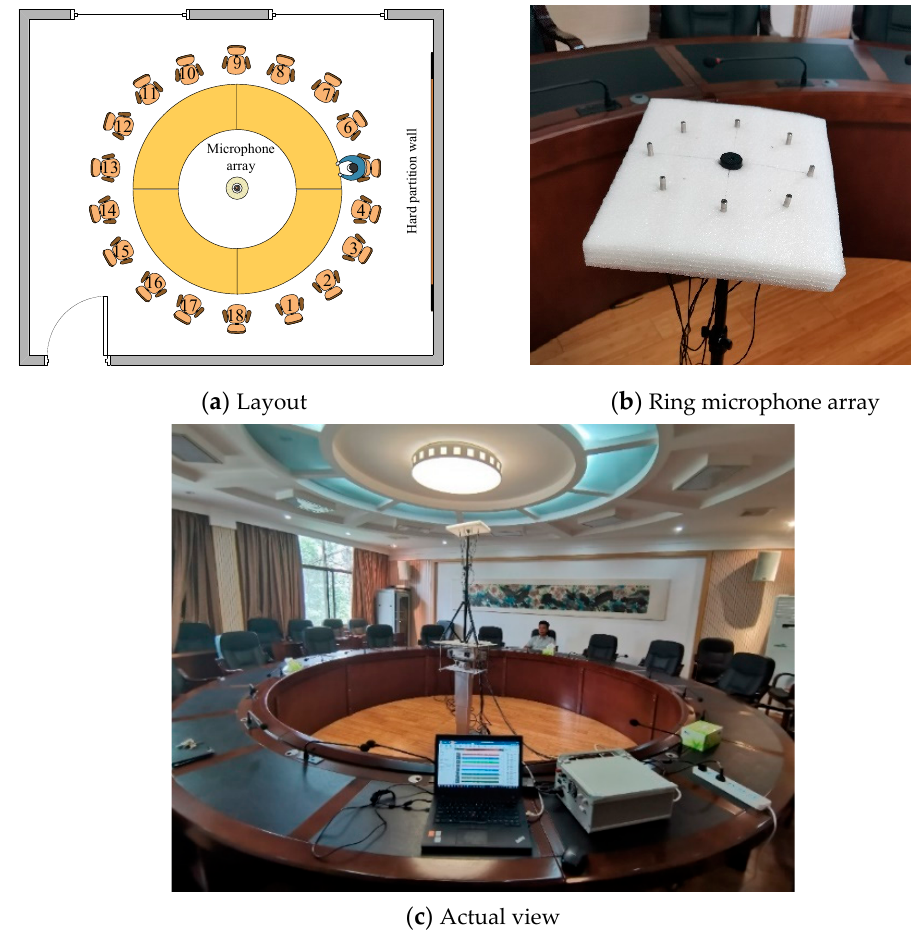
Figure 8. Layout and actual view of the meeting room. At the stage of offline database construction, a sound source was, in turn, set at the center of each seat and at the height of 1.2 m. The sound signals, i.e., a piece of music generated by a blue-tooth speaker controlled by a mobile phone, emitted from each sound source were recorded by the microphone array three times with the sampling rate of 20 KHz. A Hanning window was used to convolute the sound signals and the windowed signals were divided into frames, with a frame length of 512 points and a frame shift of 256 points. There were 1080 frames for each signal, in which 200 frames with a larger short-time energy were selected for sound source localization using SRP-PHAT. The ob- tained 3600 sample points are shown in Figure 9. Figure 9. Sample points of the localization results (18 positions).